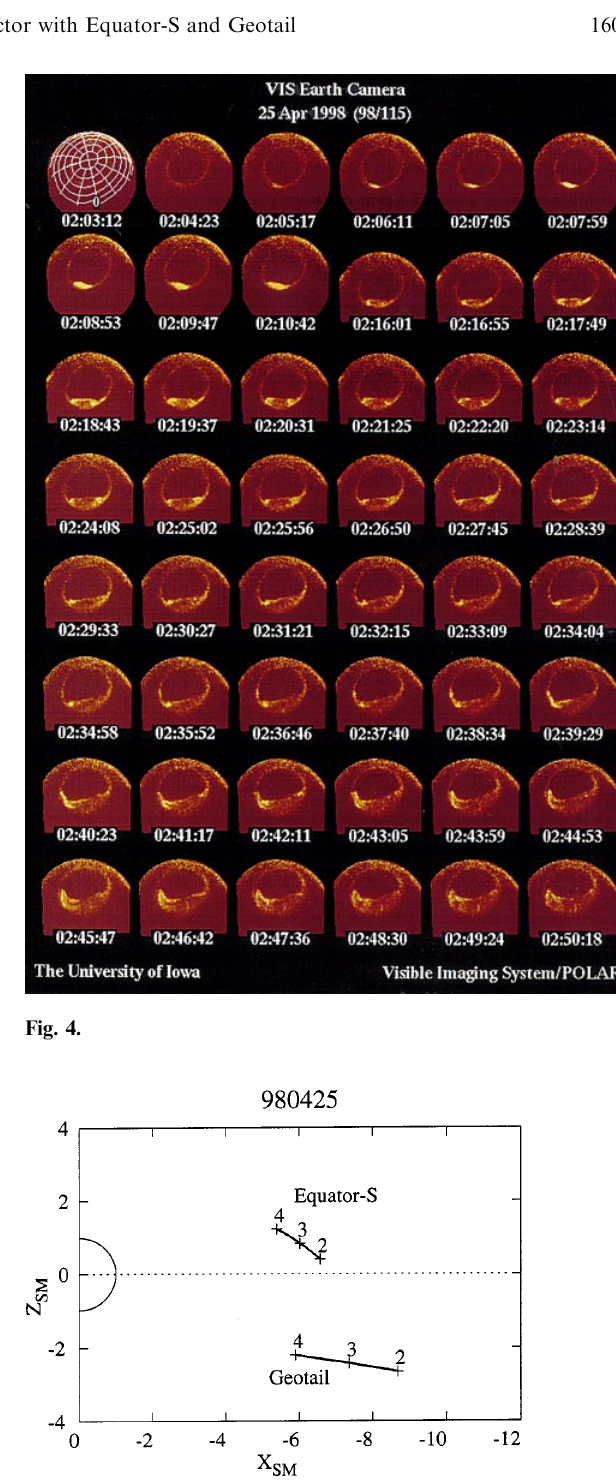
Fig. 5. The location of Geotail and Equator-S in Solar-magnetic (SM) coordinates between 0200 and